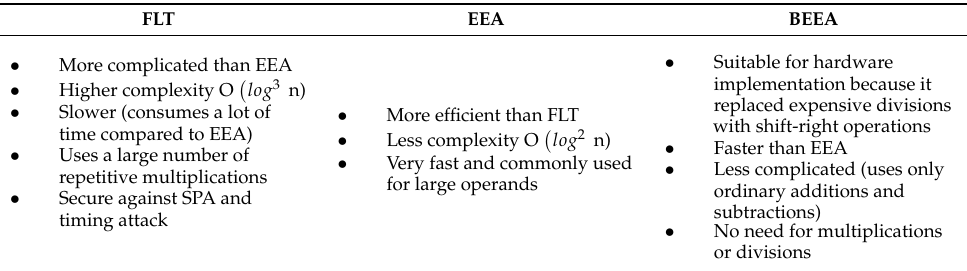
Table 1. Comparison between FLT, EEA, and BEEA